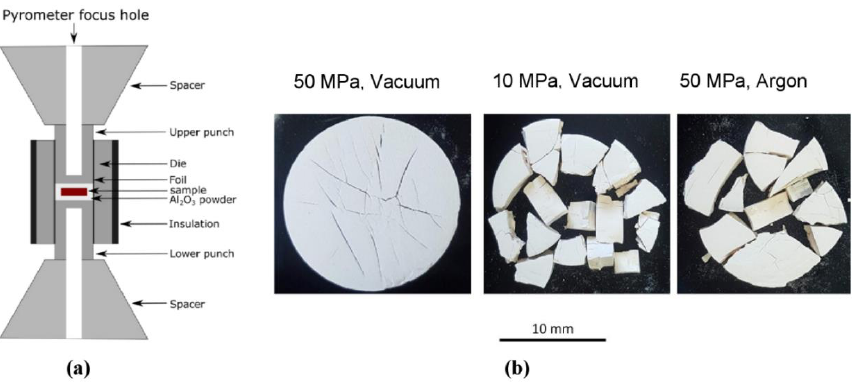
Figure 8. (a) Setup and (b) broken pellets after sintering of cold-pressed GDC10-HP sample in alumina bed with varying pressure and atmosphere. bed with varying pressure and